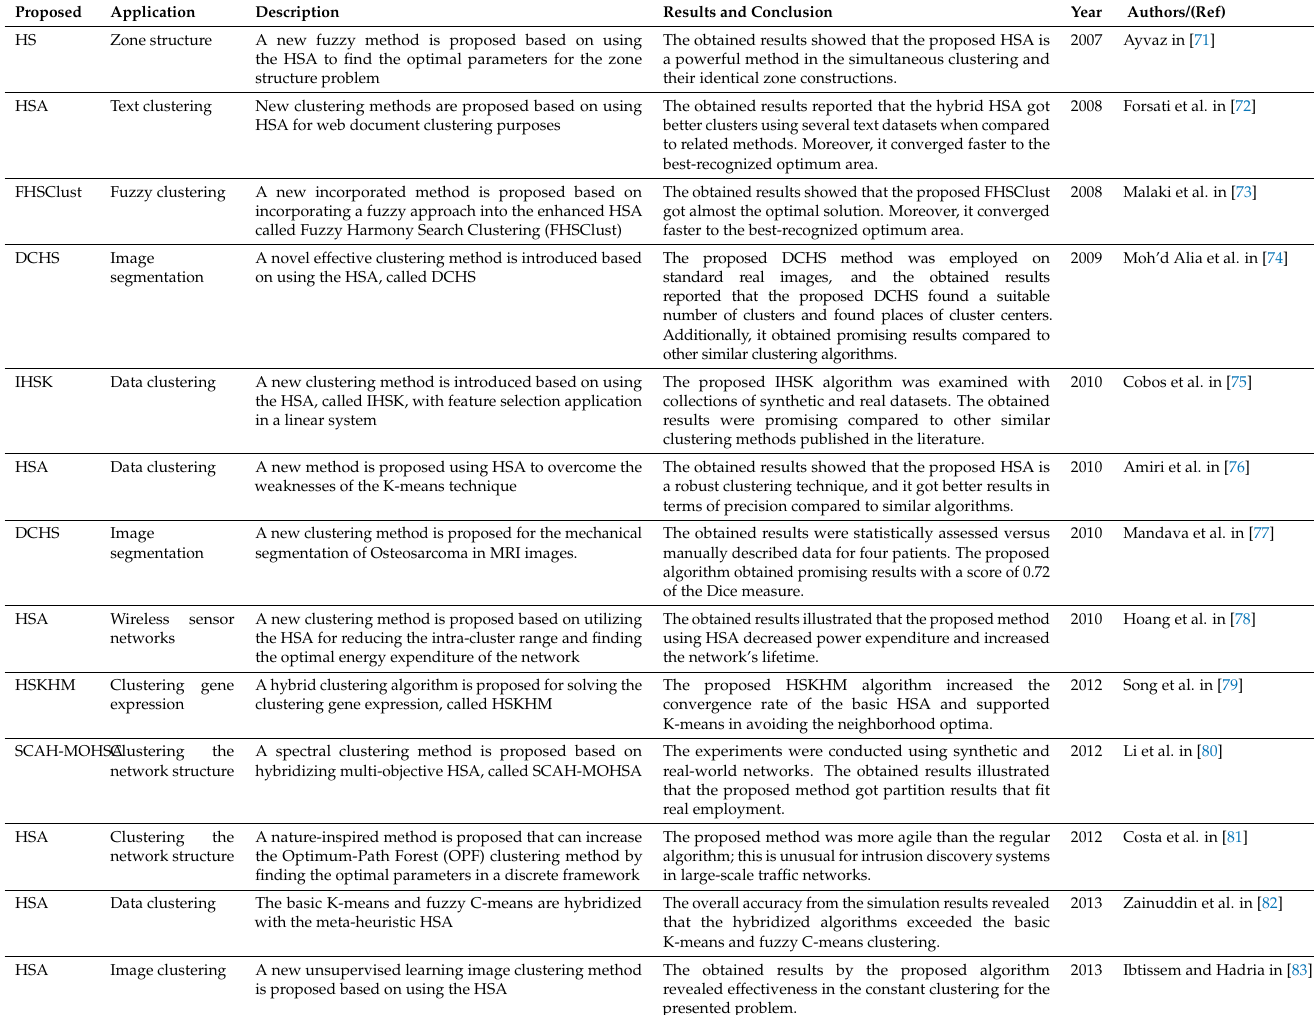
Table 2. Clustering applications of the